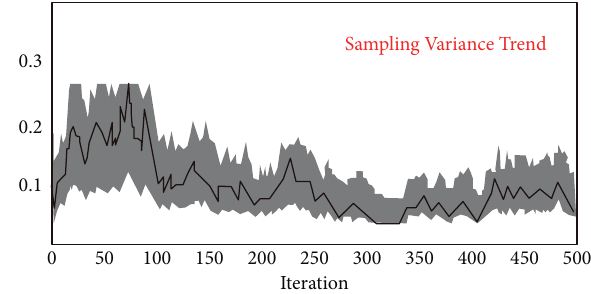
Figure 7: GWO resampling SV trend.